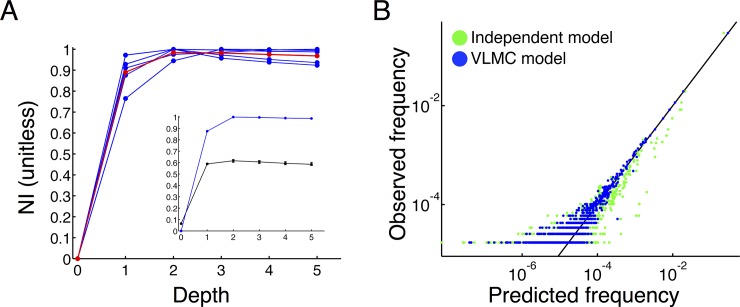
Second order statistical structure in population bursts.(A) Cross-validation of VLMC models demonstrates that the optimal memory depth for predicting the future of the burst sequence is d = 2, where the normalized sequential information (NI) approaches it asymptote of 1. Blue curves show NI as a function of model depth for each rat and session. The red curve shows the population average. Note that ~90% of the sequential structure is captured at depth d = 1 (first-order Markov model) with an improvement (~10%) at depth d = 2, after which point the VLMC models saturate. (Inset) NI as a function of depth for the fitted model (blue, Rat 1, session; all sessions are similar) compared to models fitted on ‘null sequences’ that have had neural bursts randomly permuted (black) shows that that sequential structure between neurons is a significant feature of the burst sequences. The null sequences preserve the avalanche structure, which is captured as a first-order Markov chain, but the null models saturate significantly below NI = 1 (error bars show the min and max NI for 100 permutations of the burst sequence). (B) The VLMC models predict the frequency of occurrence of each distinct burst word in the burst sequence. Log-log plots of observed versus predicted frequencies for a representative example (Rat 2) of the burst words demonstrate that the fitted VLMC model outperforms the uncorrelated model. Each point corresponds to a unique word from sleep and the color corresponds to the fitted model (blue) or independent model (green). A perfect match between the predicted and observed frequencies would correspond to points along the black line (y = x). Note that at the low frequency end the sampling error results in larger deviations in the graph from the identity line.